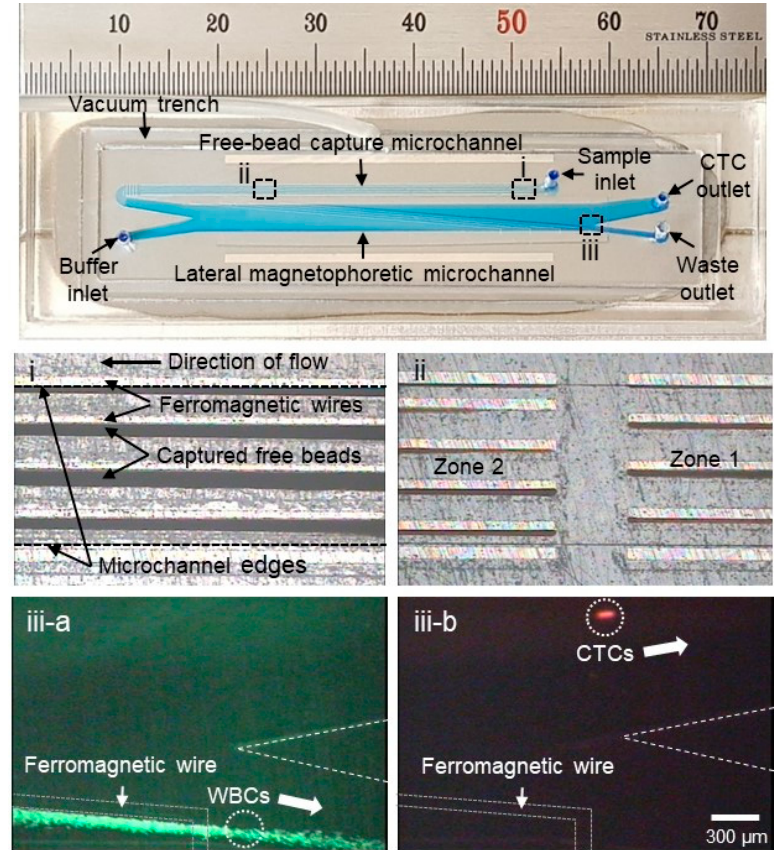
Figure 2. Photographs of the NegCTC- µ Chip, which consists of free-bead capture and lateral magnetophoretic microchannels. Enlarged views of ( i ) residual magnetic nanobeads captured on the ferromagnetic wires and ( ii ) zones 1 and 2 in the free-bead capture microchannel. In the lateral magnetophoretic microchannel, ( iii - a ) WBCs (green) bound to magnetic nanobeads are forced laterally into the waste outlet, and ( iii - b ) spiked cancer cells (red) flow into the CTC outlet.